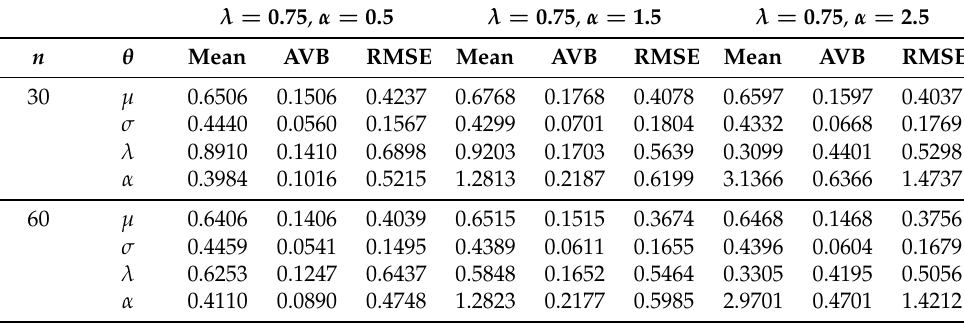
Table 2. MLE behaviors for the UPSN